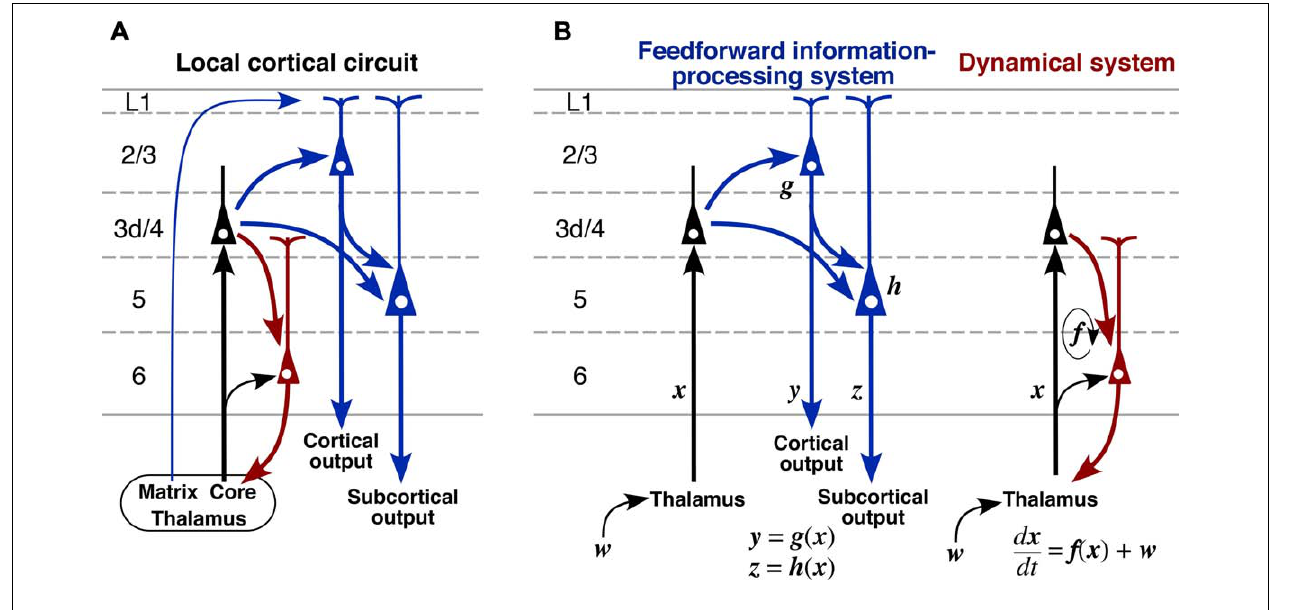
FIGURE 10 |A proposed model of cortical excitatory circuitry. (A) L3d and L4 spiny neurons receive abundant core-type or core-like thalamic inputs, whereas L2/3 and L5 pyramidal neurons accept matrix-type inputs on their apical tufts. L2/3 pyramidal and L3d/L4 spiny neurons send axons to L5 pyramidal neurons, and L2/3 and L5 pyramidal neurons project to other cortical areas and subcortical regions, respectively (blue circuit). In contrast, L6 CTNs receive thalamic inputs directly and indirectly via L3d/L4 neurons,